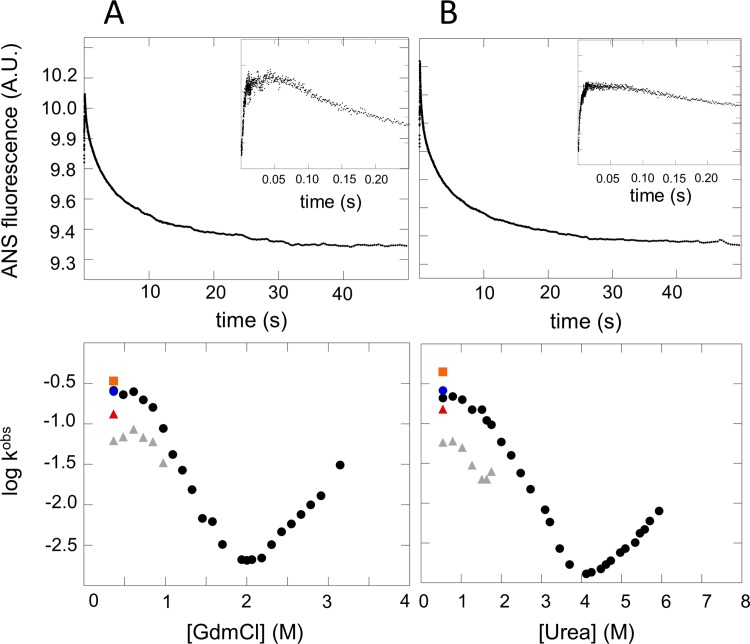
ANS binding kinetics to Interleukin-33 for the refolding reaction.(A, upper panel) A refolding trace of IL-33 in the presence of 1-Anilinonaphtalene-8-Sulfonic Acid (ANS) in 0.36 M GdmCl. (B, upper panel) Refolding of IL-33 in the presence of ANS in 0.36 M urea. Fluorescence emission of ANS was monitored upon refolding of IL-33 and shows an initial binding and release of dye in the first milliseconds of folding (inset), indicative of the formation of a short-lived intermediate state. (A, lower panel) shows the rates of refolding of IL-33 in GdmCl as determined by ANS on the corresponding chevron plot and (B, lower panel) shows the rate of IL-33 refolding in Urea as determined by ANS on the corresponding chevron plot. The ANS binding rate is shown with an orange square while the two phases of ANS release are shown with a blue circle and red triangle, respectively.